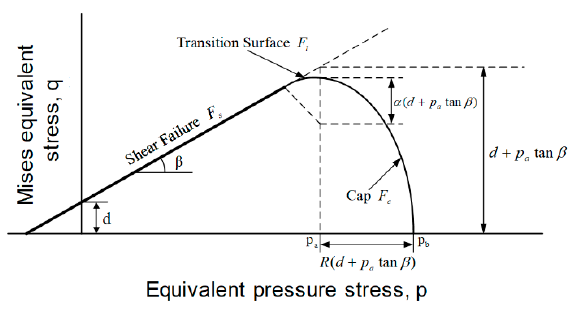
Figure 15. Failure criterion of Cap plasticity for concrete materials.